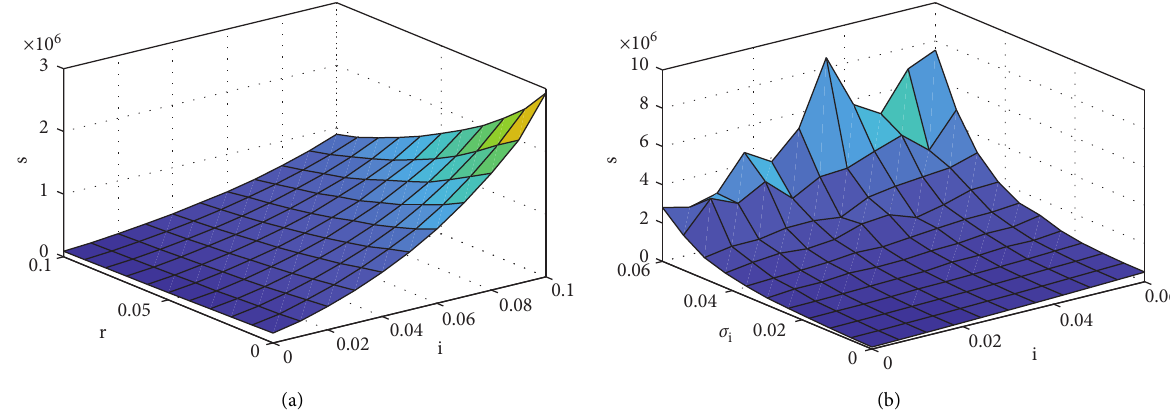
Figure 9: Present value of subsidies S (unit: CNY 100,000) based on (a) r and i and (b) σ Figure 10(b) simulates the effect of interest rate volatility and inflation volatility on the subsidies’ present value. It is observable that the slope for inflation volatility effect on the present value of subsidies exceeds that of interest rate volatility. Therefore, the present value of subsidies is characterised by greater sensitivity to inflation volatility.